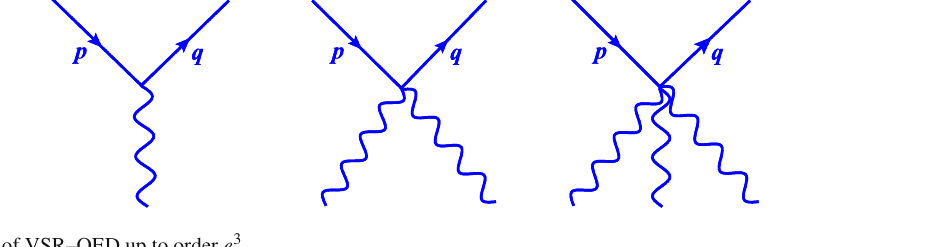
Fig. 1 Feynman graphs of VSR–QED up to order e 3